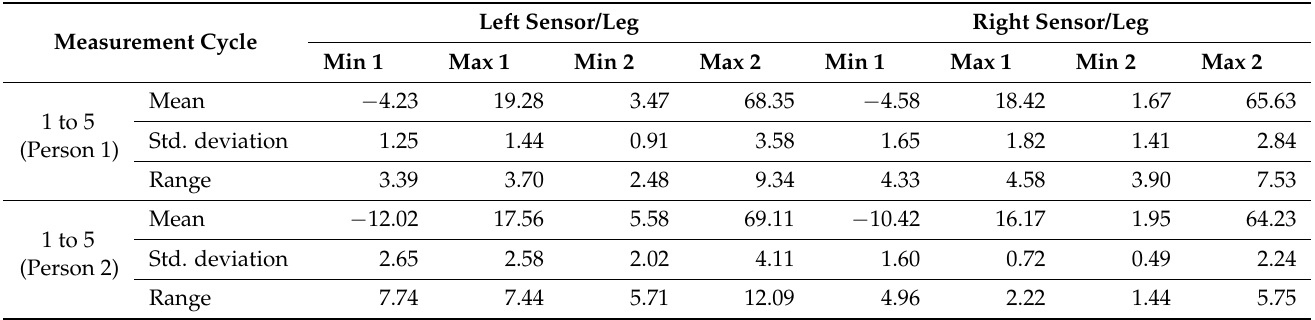
Table A2. Measured knee angles in degree ( ◦ ) separated by the main events and